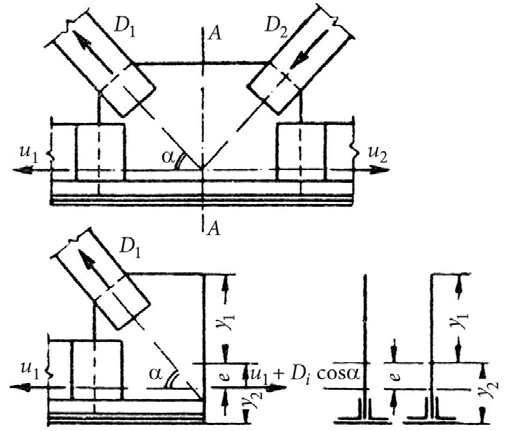
Fig. 5. Analysis of gusset plate based on beam analogy